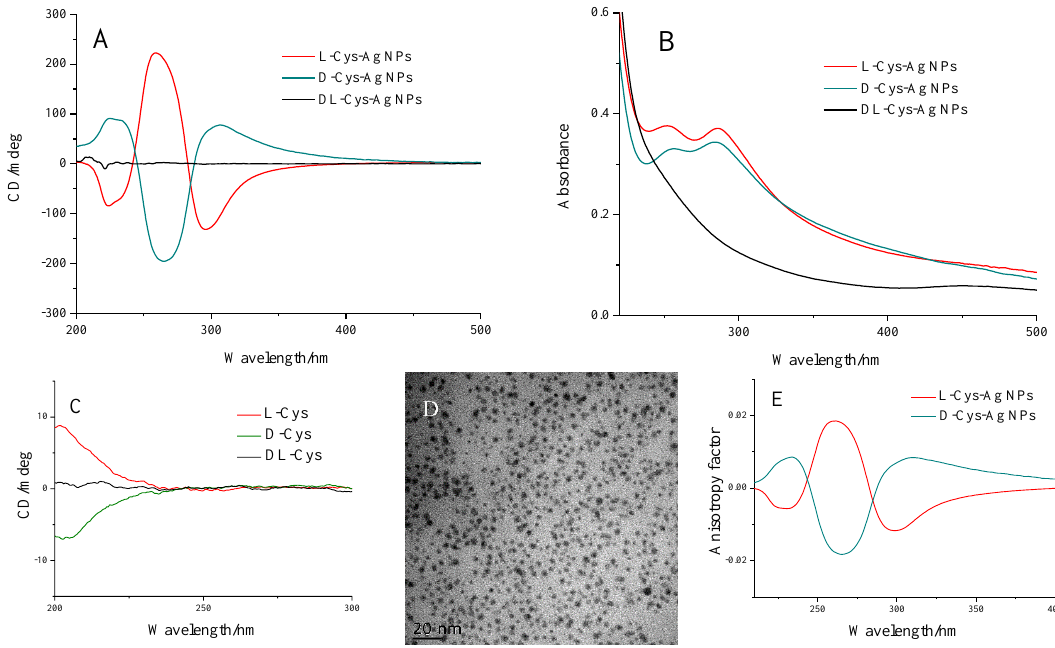
Figure 1. ( A ) Circular dichroism (CD) and ( B ) UV-Vis absorption spectra of L-Cys, D-Cys and DL-Cys capped Ag nanoparticles (NPs); ( C ) CD spectra of L-Cys, D-Cys and DL-Cys solutions; ( D ) Representative transmission electron microscopy (TEM) image of L-Cys capped Ag NPs; ( E ) Anisotropy factors (g-factors) for L-Cys and D-Cys capped Ag NPs.